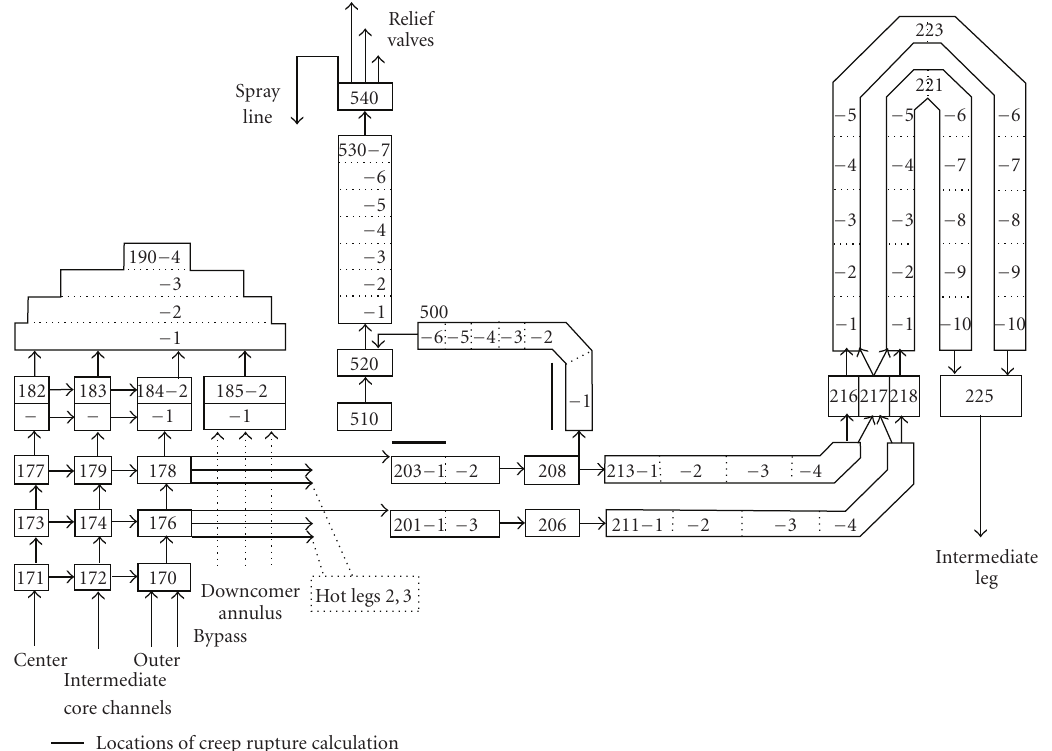
Figure 11: G¨osgen split hot leg nodalization used for RELAP/SDAPSIM and SCDAP/RELAP5.